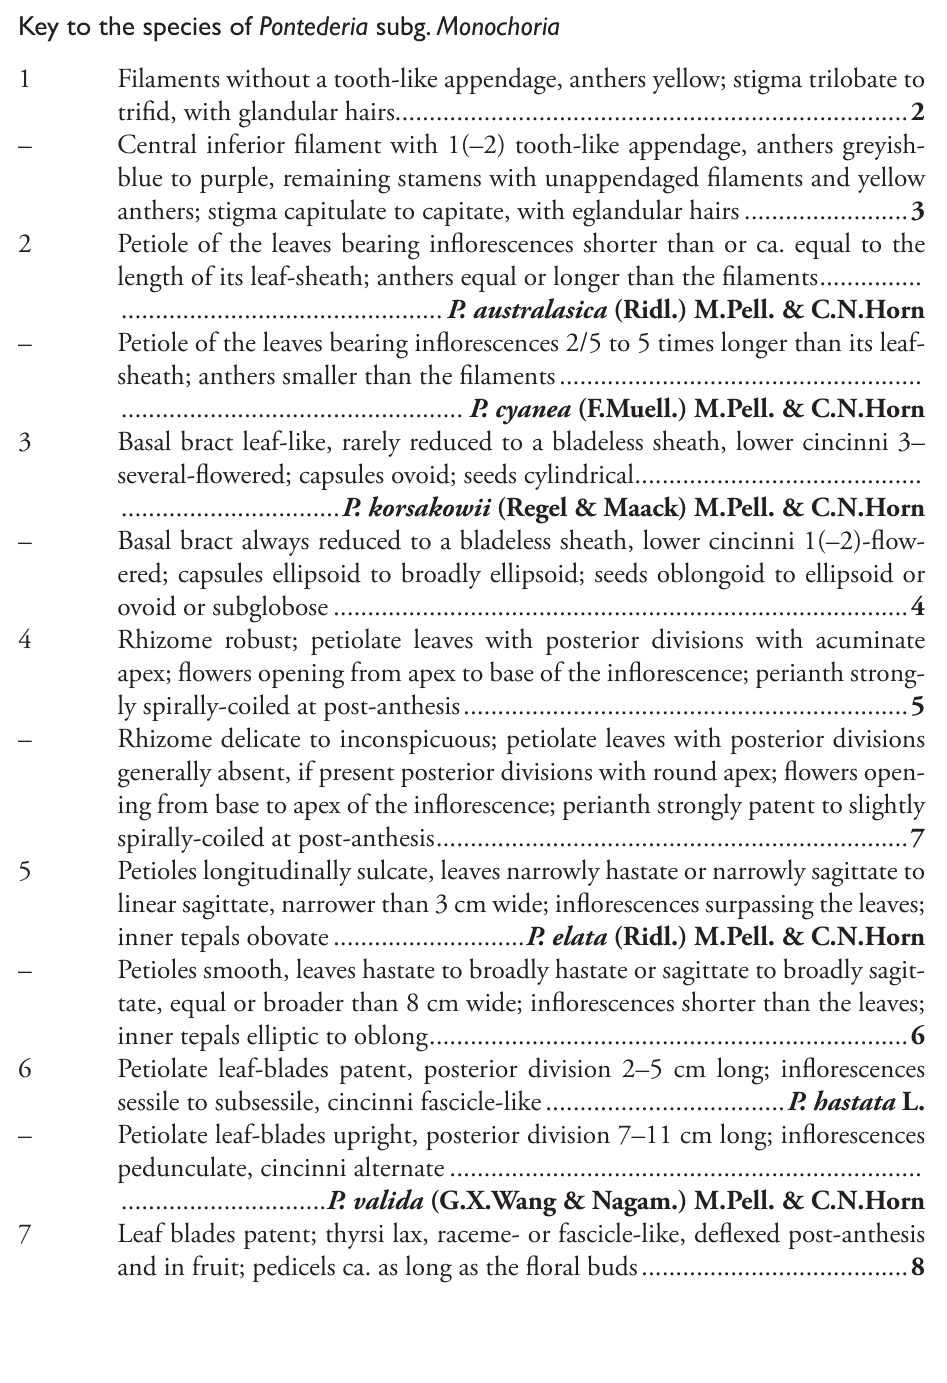
Filaments without a tooth-like appendage, anthers yellow; stigma trilobate to Central inferior filament with 1(–2) tooth-like appendage, anthers greyish- blue to purple, remaining stamens with unappendaged filaments and yellow anthers; stigma capitulate to capitate, with eglandular hairs ........................ 3 Petiole of the leaves bearing inflorescences shorter than or ca. equal to the length of its leaf-sheath; anthers equal or longer than the filaments ............... – Petiole of the leaves bearing inflorescences 2/5 to 5 times longer than its leaf-